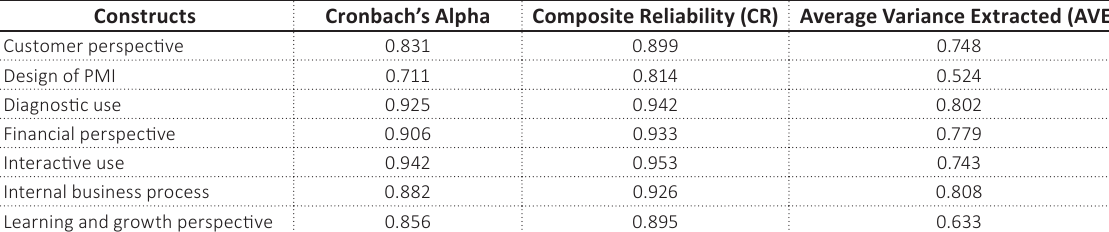
Table 2. Quality assessment for the final measurement model